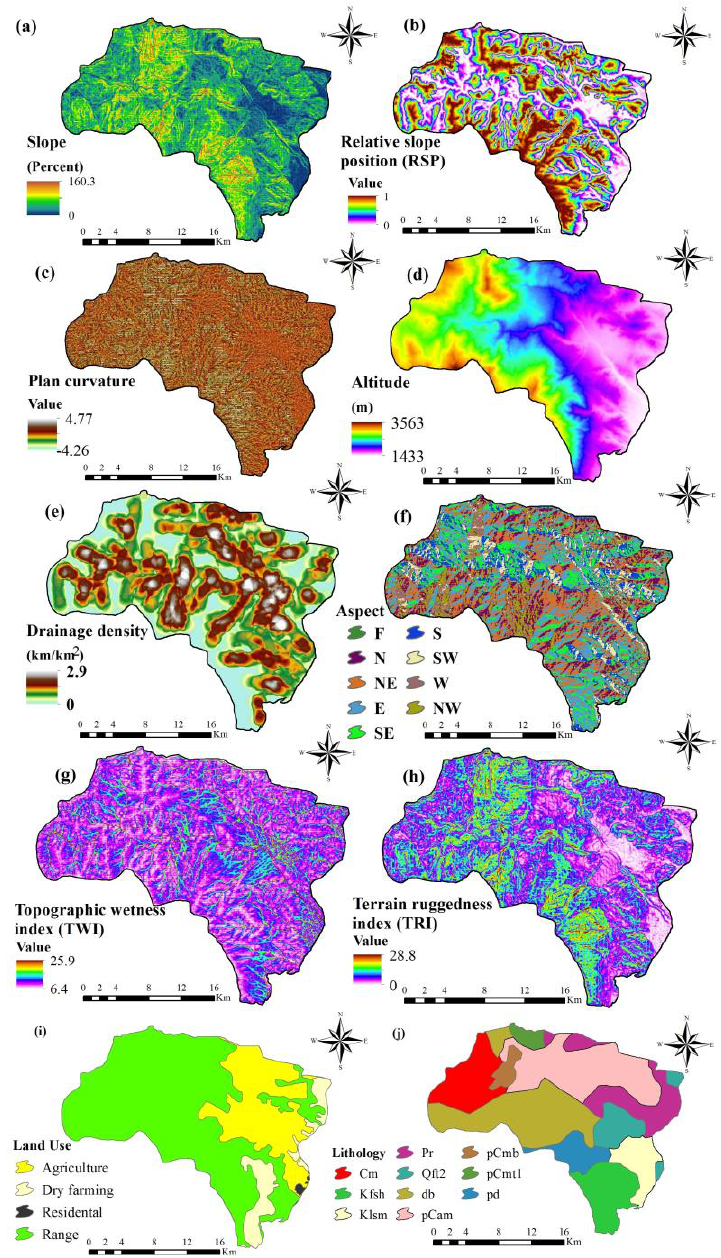
Figure 4. Maps showing the 10 groundwater conditioning factors considered in groundwater mapping in Piranshahr Watershed, Iran. ( a ) Slope, ( b ) relative slope position (RSP), ( c ) plan curvature, ( d ) altitude, ( e ) drainage density, ( f ) aspect, ( g ) topographic wetness index (TWI), ( h ) terrain ruggedness index (TRI), ( i ) land use, and ( j ) lithology.